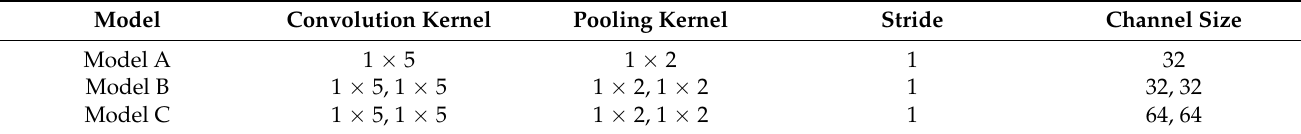
Table 4. Different parameter settings.